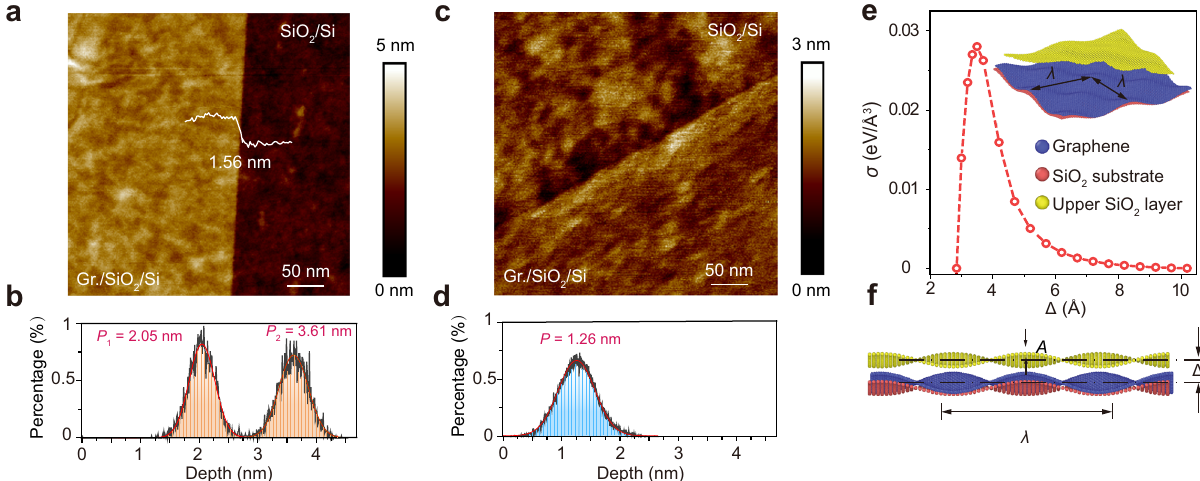
Fig. 3 The conformal contact of graphene with destination substrates. a – d AFM image and height histogram of as-transferred graphene edges on SiO 2 /Si substrates by conventional PMMA-based techniques ( a , b ) and OVMs-modi fi ed supporting fi lms (cedrol (10 wt%)/PMMA) ( c , d ). The distance between two peaks in the height histogram indicates the height of the as-transferred graphene edge is 1.56 nm by the conventional PMMA-based method. In contrast, the single peak in the height histogram of clean graphene edge re fl ects the smaller height difference across the edge and the fi ne conformity. e – f The adhesion in the collective interaction between atoms in graphene and the SiO 2 /Si substrates as a function of the distance between graphene and substrates ( e ) and the front view of the corresponding model structure ( f ). e the overlook view of the corresponding model structure. Δ is the average separation distance between the graphene and SiO 2 /Si layer. A and λ are the amplitude and wavelength of the surface corrugations,